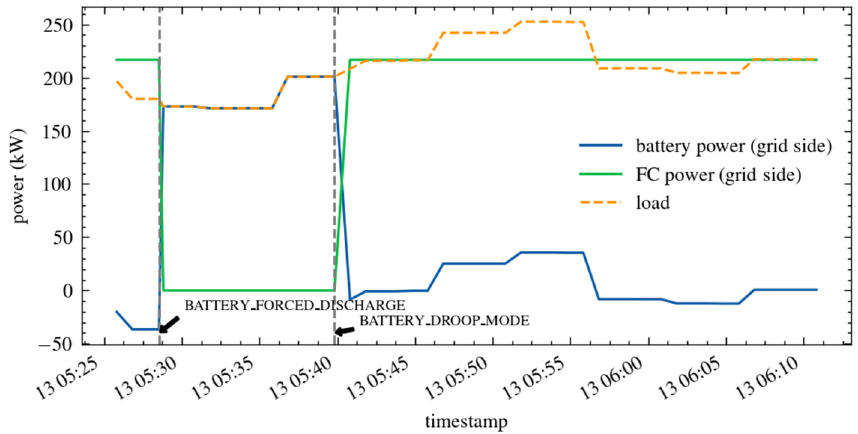
Figure 15. Grid-side powers in Scenario 3: zoom on time instants corresponding to temporary working conditions of the battery (timestamp is in “day hours:minutes” format).